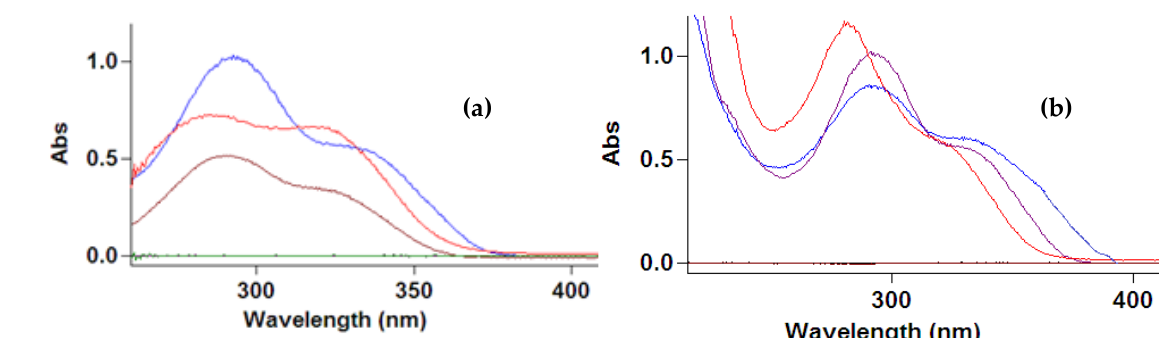
Figure 5. UV-Vis spectra of ( a ) Nd 3+ -HCCA: free ligand (blue line), solution (brown line) and solid (red line); ( b ) UO 22+ - HCCA: free ligand (violet line), solution (red line) and solid (blue line).